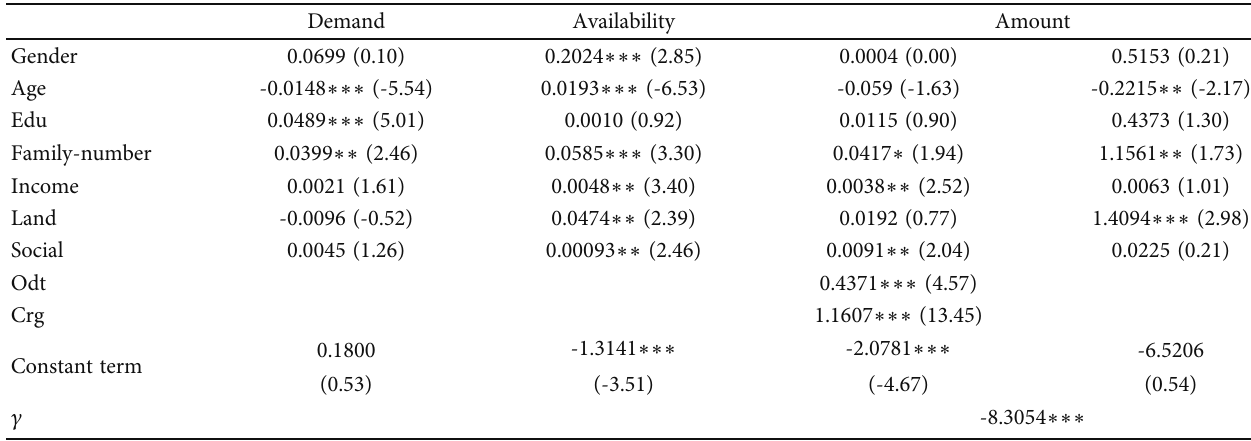
Table 1: Regression analysis